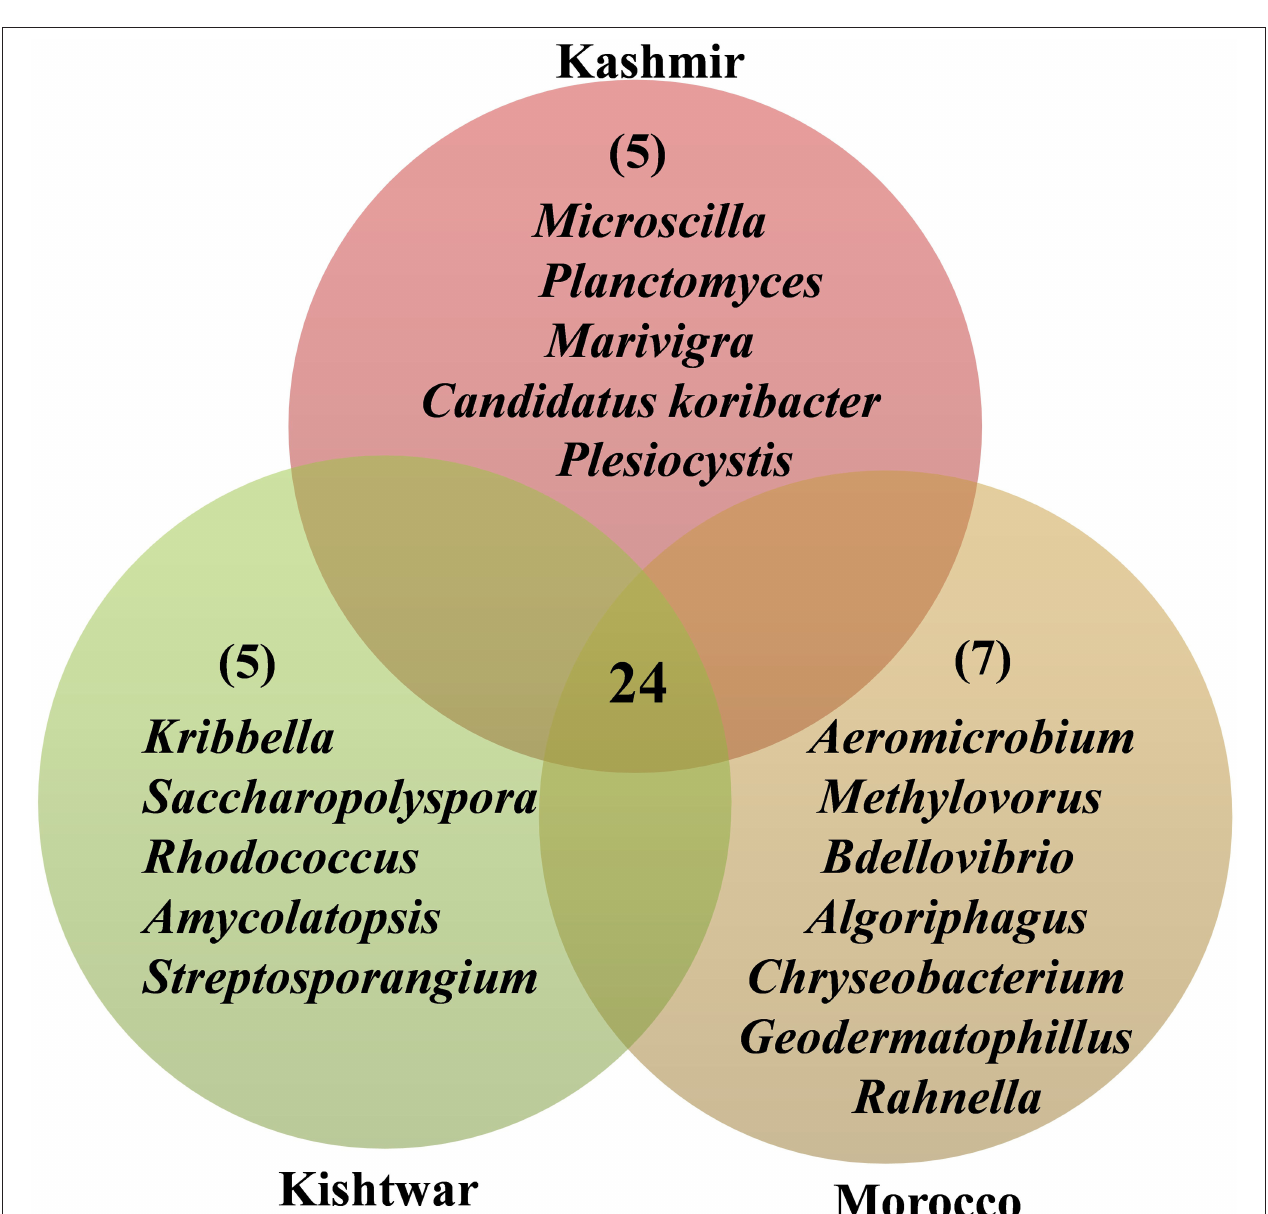
FIGURE 13 | Representing the number of common and unique genera identified in three geographical locations. Twenty-four common genera in all the three geographical locations are referred as the core microbiome of saffron. Five genera were unique to Kishtwar, seven to Morocco, and five to Kashmir.